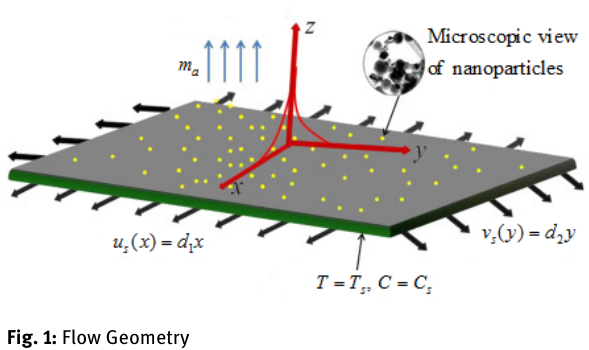
After the careful implementation of above enunciated hypothesis the momentum and energy equations of